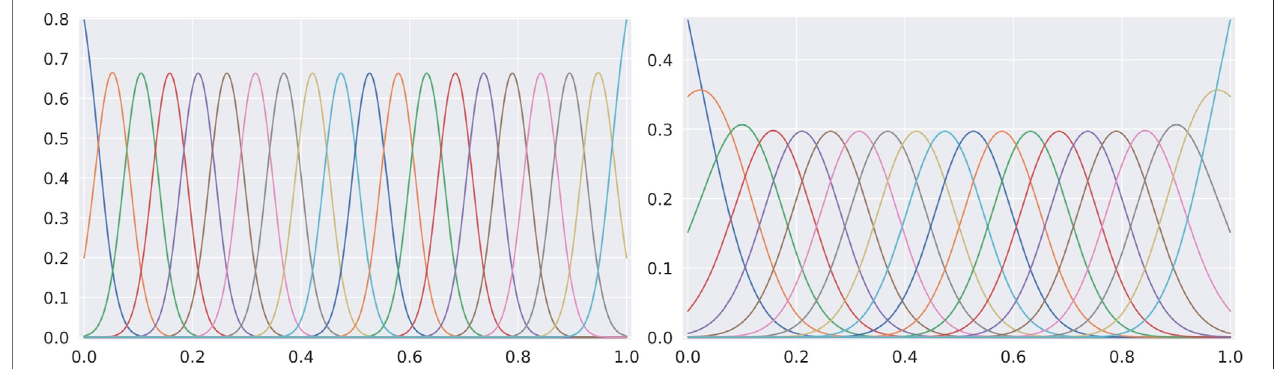
FIGURE 2 | Two covers of RBF kernels with different scales: δ (cid:1) 0 . 002 and δ (cid:1) 0 . 01. The x -axis corresponds to the unit interval where the nodes of the graph are mapped. The y -axis represents the value of the normalized RBF kernels.